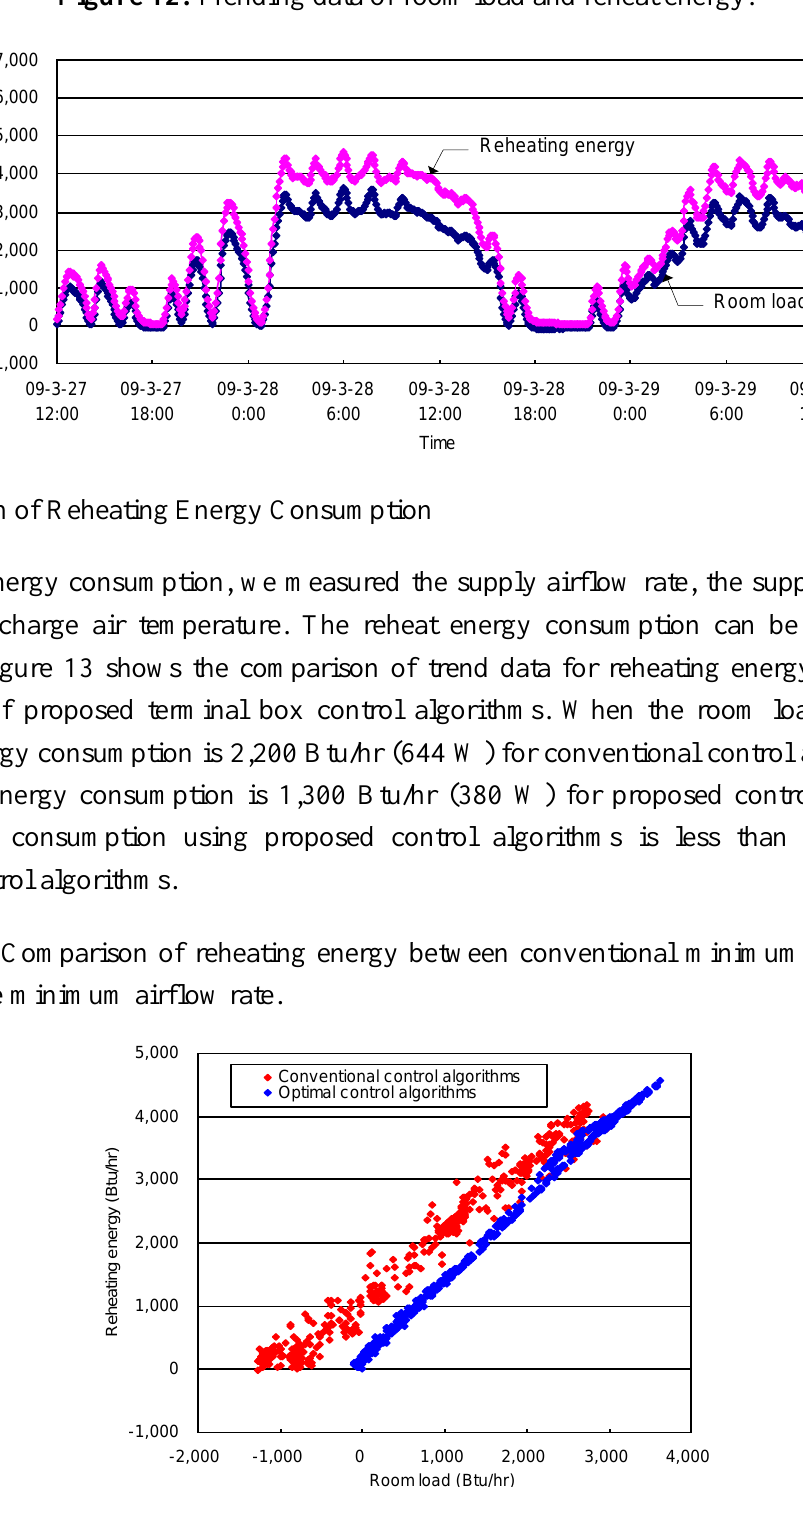
Figure 12. Trending data of room load and reheat energy.